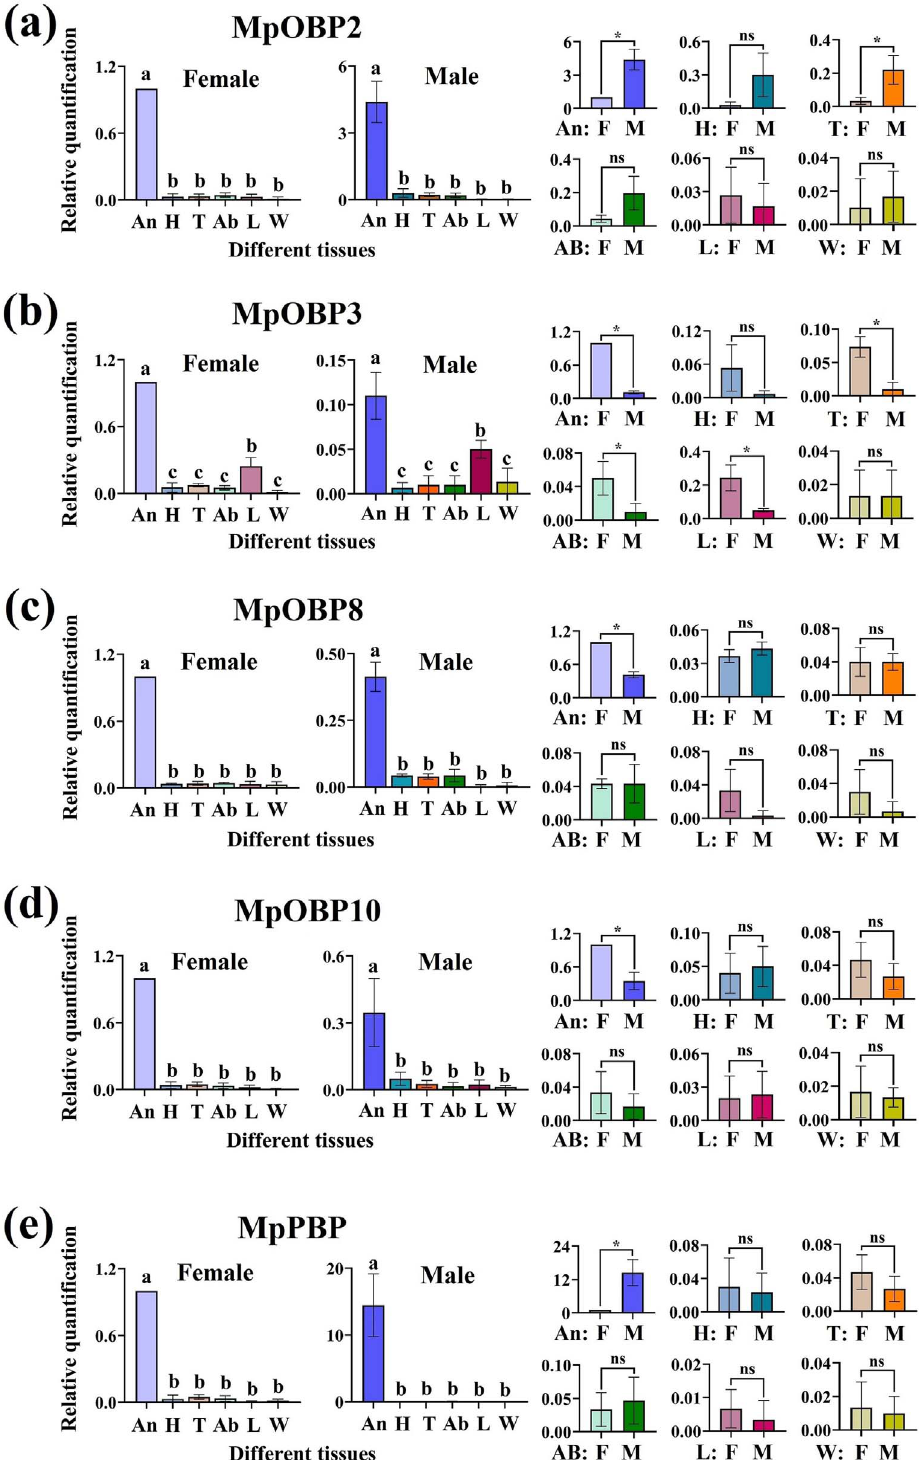
Figure 6. Relative quanti fi cation of M. pallidipes OBPs in different tissues of female and male wasps. (a – e) MpOBP2 , MpOBP3 , MpOBP8 , MpOBP10 , and MpPBP , respectively. The two charts on the left represent comparisons of OBP expression in different tissues, and the six small charts on the right represent comparisons of female and male OBP expression. Tissue type or sex is on the x -axis and relative quanti fi cation of M. pallidipes OBPs is on the y -axis. Bars represent standard deviations. An: antennae, H: heads, T: thoraxes, Ab: abdomens, W: wings, L: legs; F: female, M: male. Different lower-case letters indicate a signi fi cant difference (one-way ANOVA, p < 0.05). ns means no signi fi cant difference and * means a signi fi cant difference ( t -test, p <